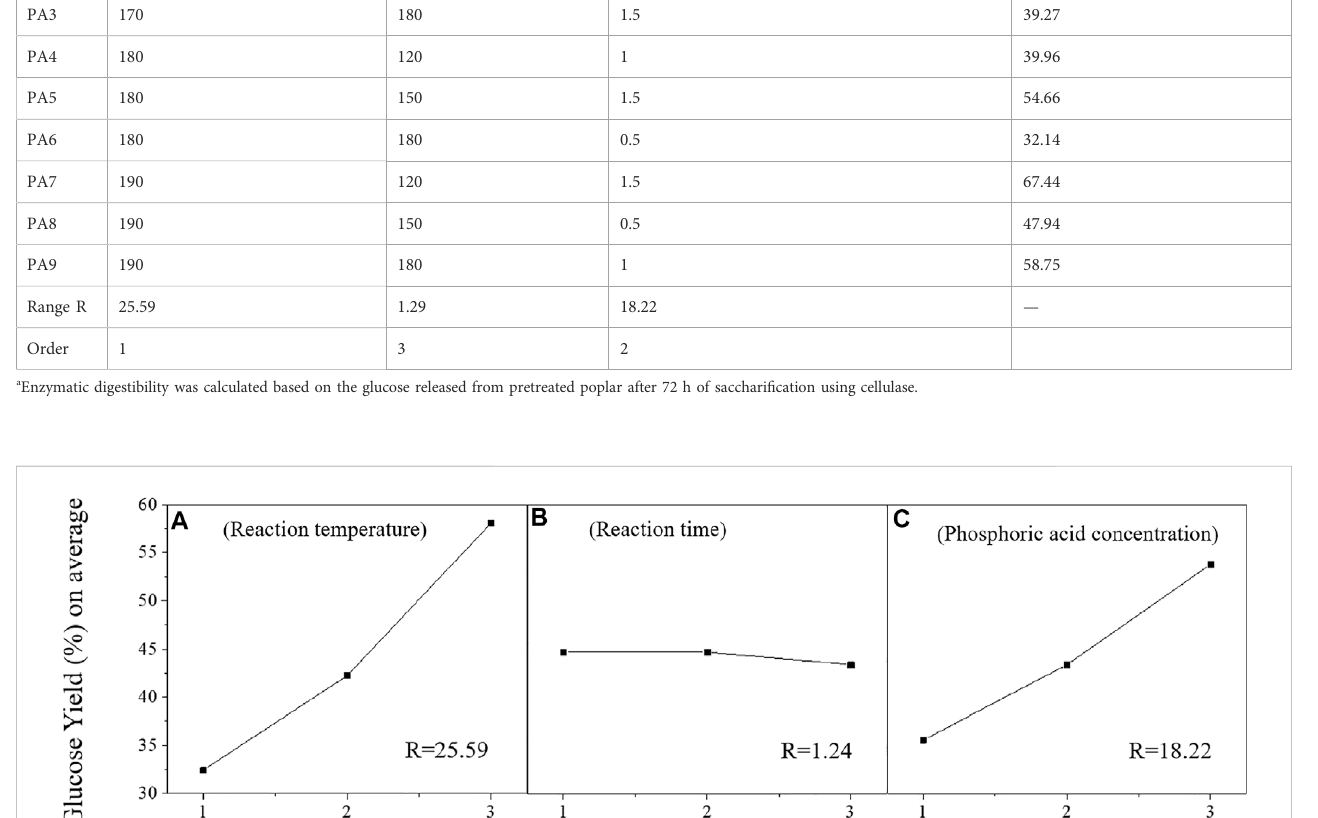
(Figure 1; Table 2), the optimal reaction conditions were 190 ° C of reaction temperature, 150 min reaction time, and 1.5% v/v of phosphoric acid concentration.